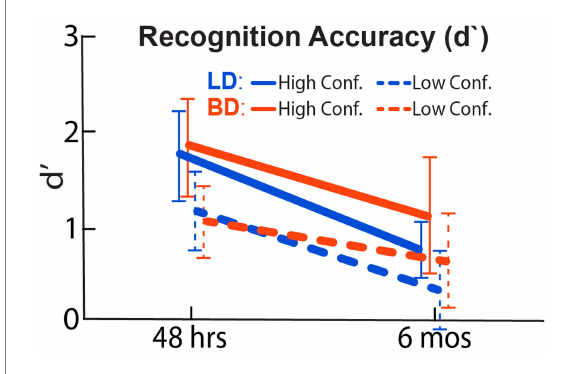
FIGURE 2 Recognition accuracy expressed as a standardized, d-prime (d’) index calculated from the hit and false-alarm rates. BD and LD groups did not differ at either 48-h or 6-mos delay. As expected, lower recognition accuracy was found after a 6-mos retention